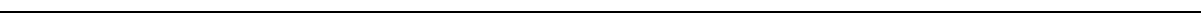
Fig. 4 Block in endosome-to-TGN traf fi cking in WDR11-knockout cells. a Wide fi eld image of a mixed population of wild-type and WDR11-knockout cells double labelled for WDR11 and CIMPR. CIMPR has a more peripheral pattern in the knockout cells. b Cells were allowed to endocytose fl uorescent EGF for 45 min, then double labelled for CIMPR. Representative confocal images show more colocalisation of CIMPR with endocytosed EGF in the knockout cells. c Representative wide fi eld images of CD8-CIMPR-expressing cells that were allowed to endocytose anti-CD8 for 15 min, then washed and chased for 45 min. In the wild-type cells, much more antibody reaches the Golgi region (de fi ned by anti-GLG1) than in the knockout cells. Scale bars: 20 µ m. d Quanti fi cation of mean CIMPR-labelling intensity colocalising with internalised EGF ( N ≥ 20 cells/cell line; three independent experiments). e Quanti fi cation of the antibody uptake results by automated microscopy in both CD8-CIMPR- and CD8-CPD-expressing cells. Two areas were de fi ned: Golgi (GLG1-positive) and non-Golgi (using a whole cell stain and then subtracting the GLG1-positive region). The ratio of Golgi-to-non-Golgi CD8 fl uorescence was calculated for each cell line ( ≥ 500 cells were measured per cell line in three independent experiments). Error bars: S.E.M. Data were tested for signi fi cance by unpaired two-tailed t -tests ( d ) and one-way ANOVA and Bonferroni post hoc test ( e ). *** P ≤ 0.001, ** P ≤